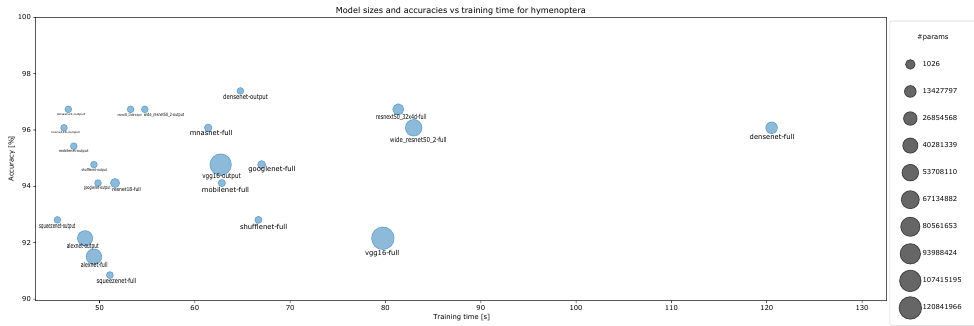
Figure A12. Accuracy vs. training time and model size for MNIST for ten-episode training.